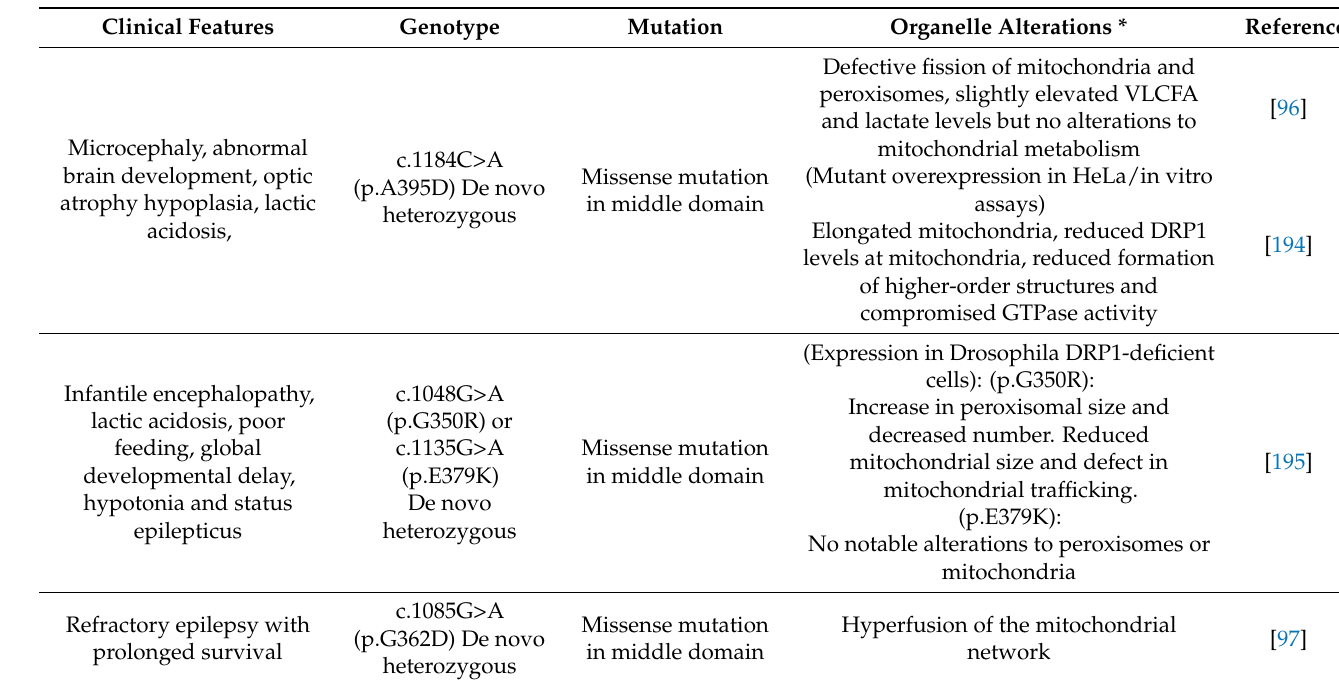
Table A1. Gene—DNM1L; Protein—dynamin 1-related protein (DRP1); Function—mediates mito- chondrial and peroxisomal division. * Data from patient-derived cells or plasma unless otherwise